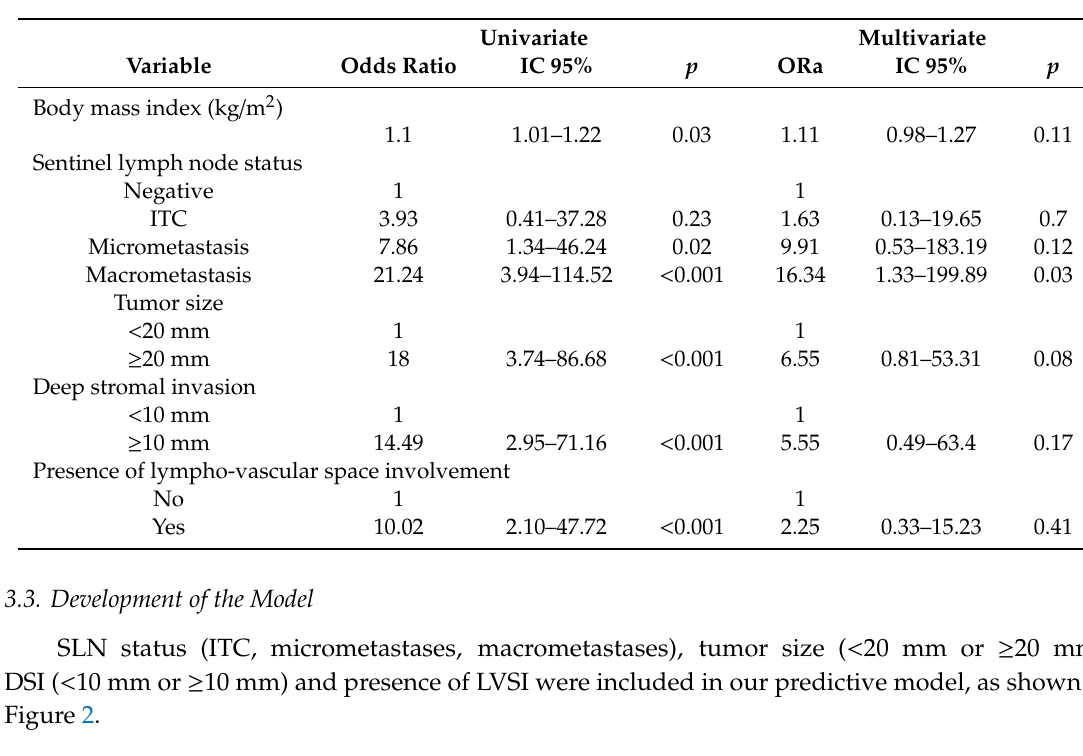
J. Clin. Med. 2020 , 9 , x FOR PEER REVIEW Figure 2.